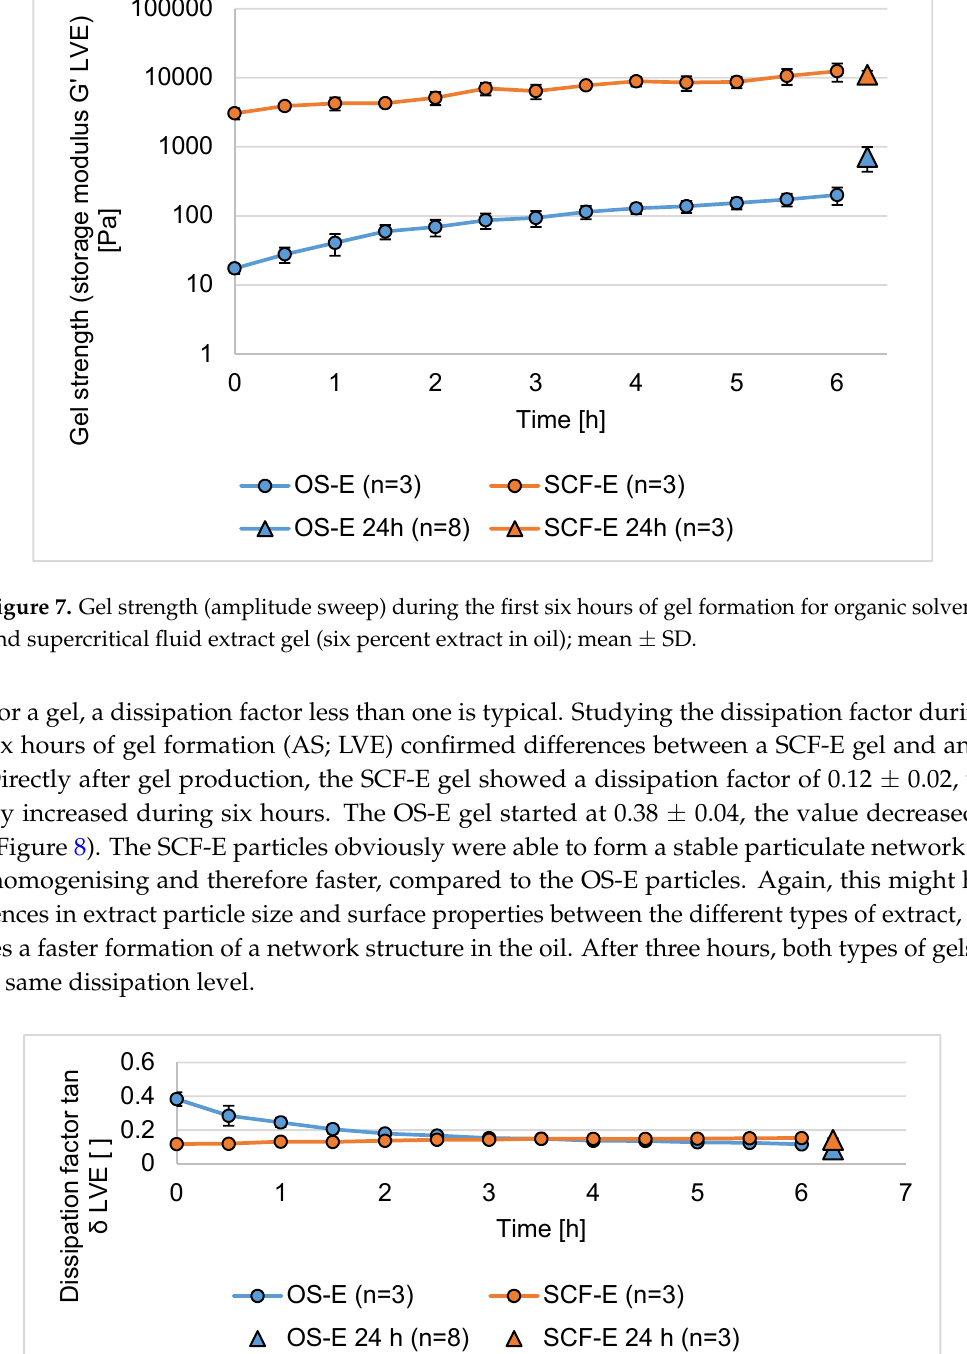
Figure 8. Dissipation factor (amplitude sweep) during the first six hours of gel formation for organic solvent and supercritical fluid extract gel (six percent extract in oil); mean ± SD.